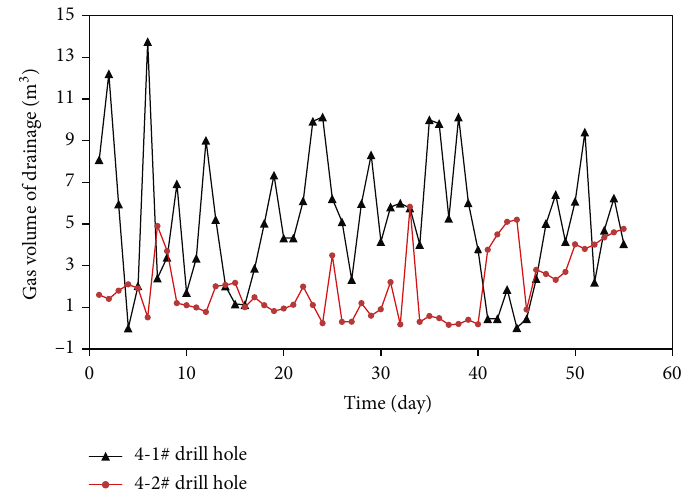
Figure 9: Gas extraction in the borehole group 4#.